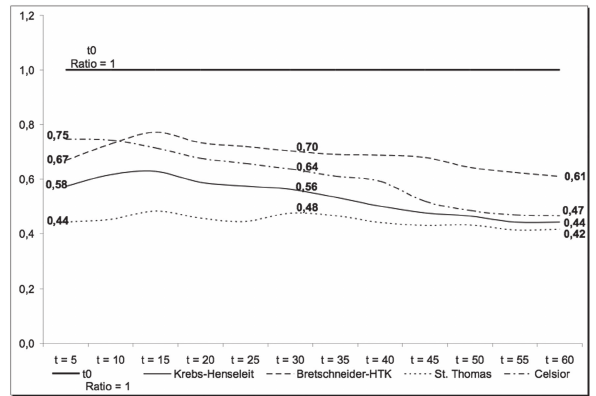
Fig. 4 - Maximum rate of fall in left ventricular pressure (-dP/dt), according to the solution. Reperfused hearts were monitored for 60 min with the following solutions: Krebs-Henseleit Buffer, Bretschneider-HTK, St. Thomas No. 1, and Celsior. Baseline was calculated after stabilization and prior to treatment